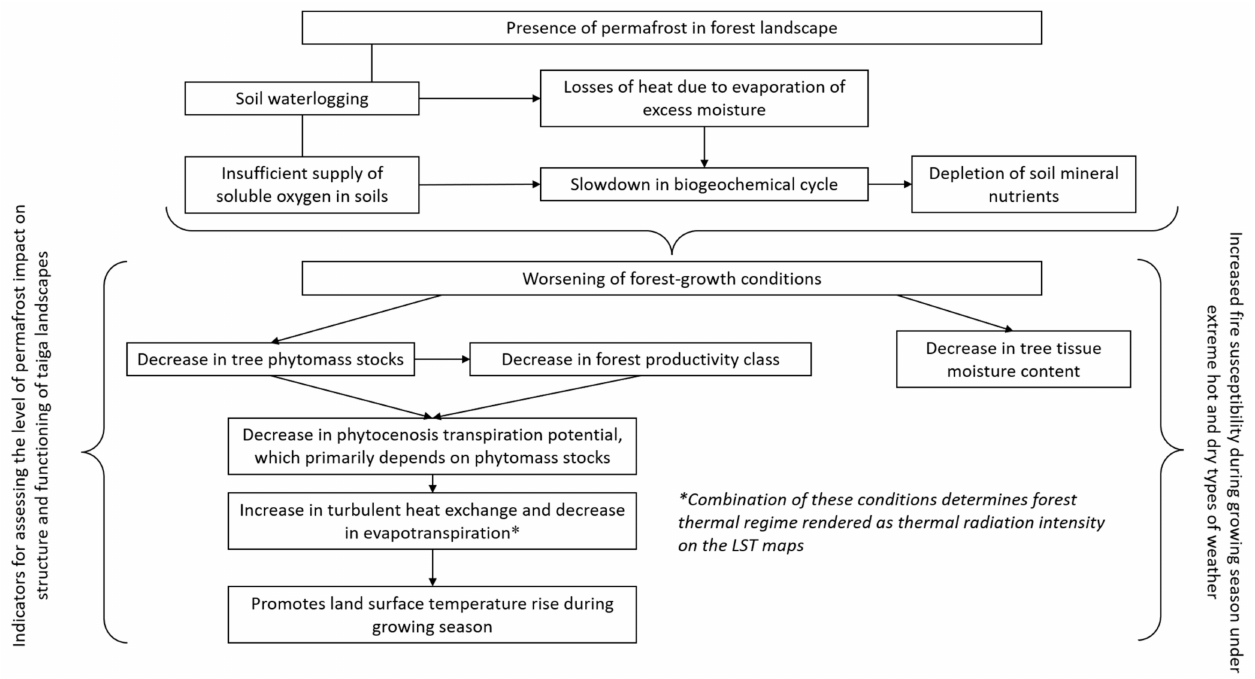
Figure 3. Conceptual schematic representation of geocryological conditions in the boreal